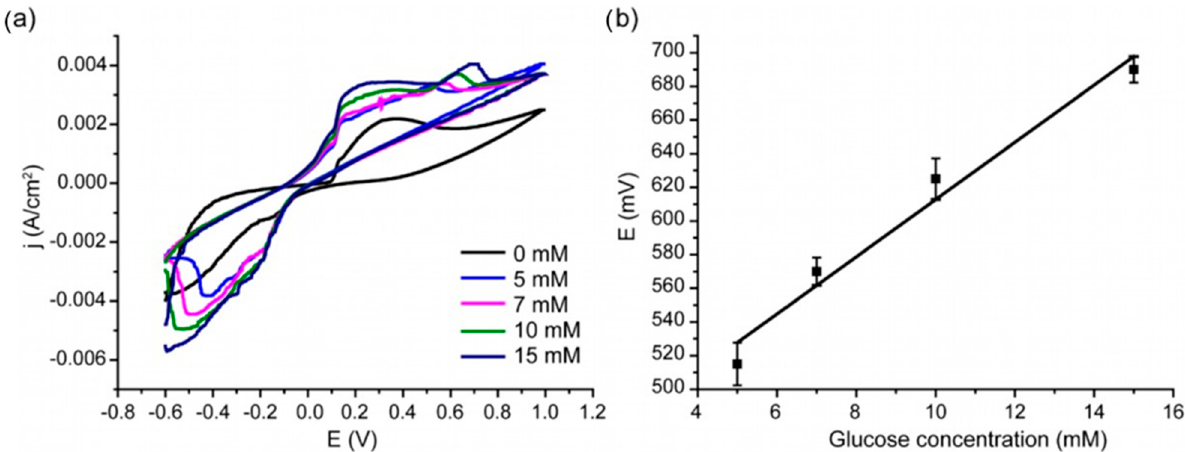
Figure 6. ( a ) CVA measured in the presence of different concentrations of glucose, third cycle; ( b ) calibration curve. ( b ) calibration curve.